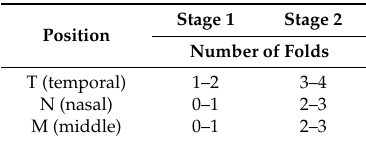
Table 2. Staging of conjunctivochalasis (CCH).